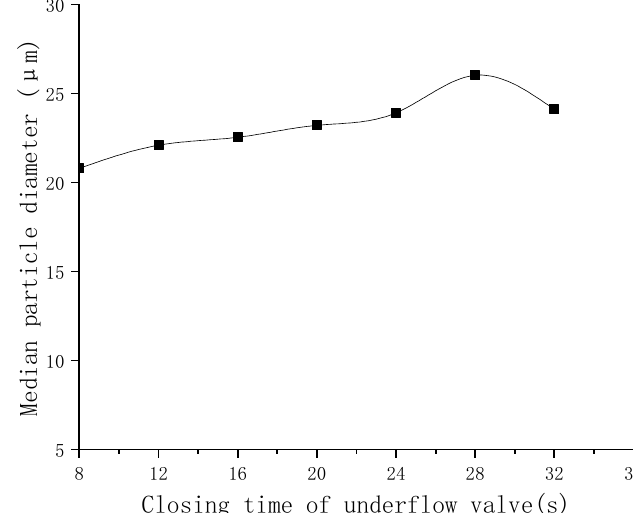
Figure 18. Effect of closing time of the underflow valve on overflow concentration.